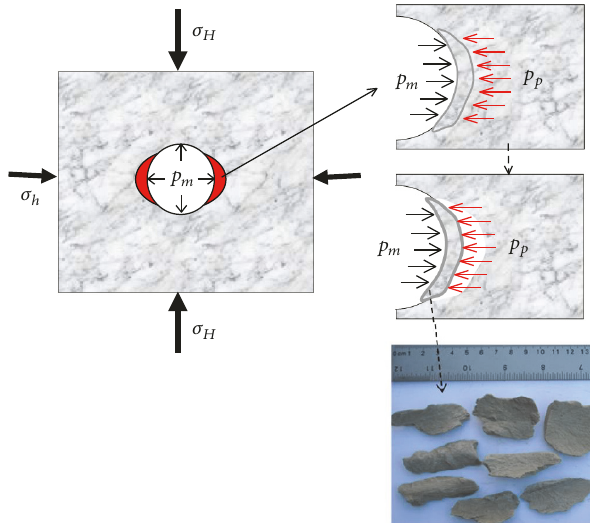
Figure 9: Schematic representation of wellbore spalling/chips for a higher pore pressure than the mud pressure (underbalanced drilling condition) in a vertical borehole. Upper part illustrates the high pore pressure that blows rock chips into wellbore; the bottom picture shows spiky and concaved cuttings resulting from the insufficient mud weight.